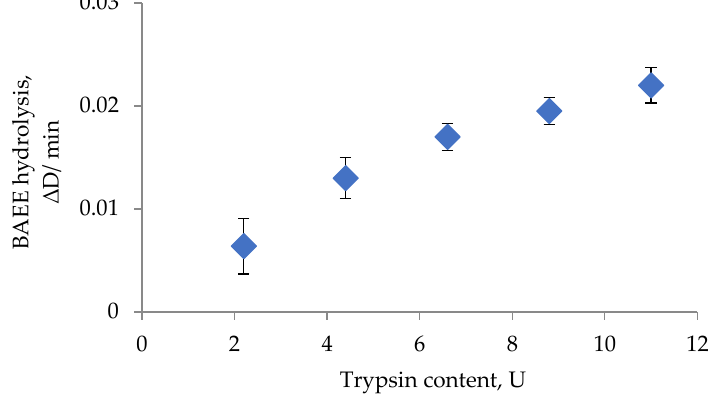
Figure 1. BAEE-hydrolysis rate versus trypsin content in the reaction mixture.